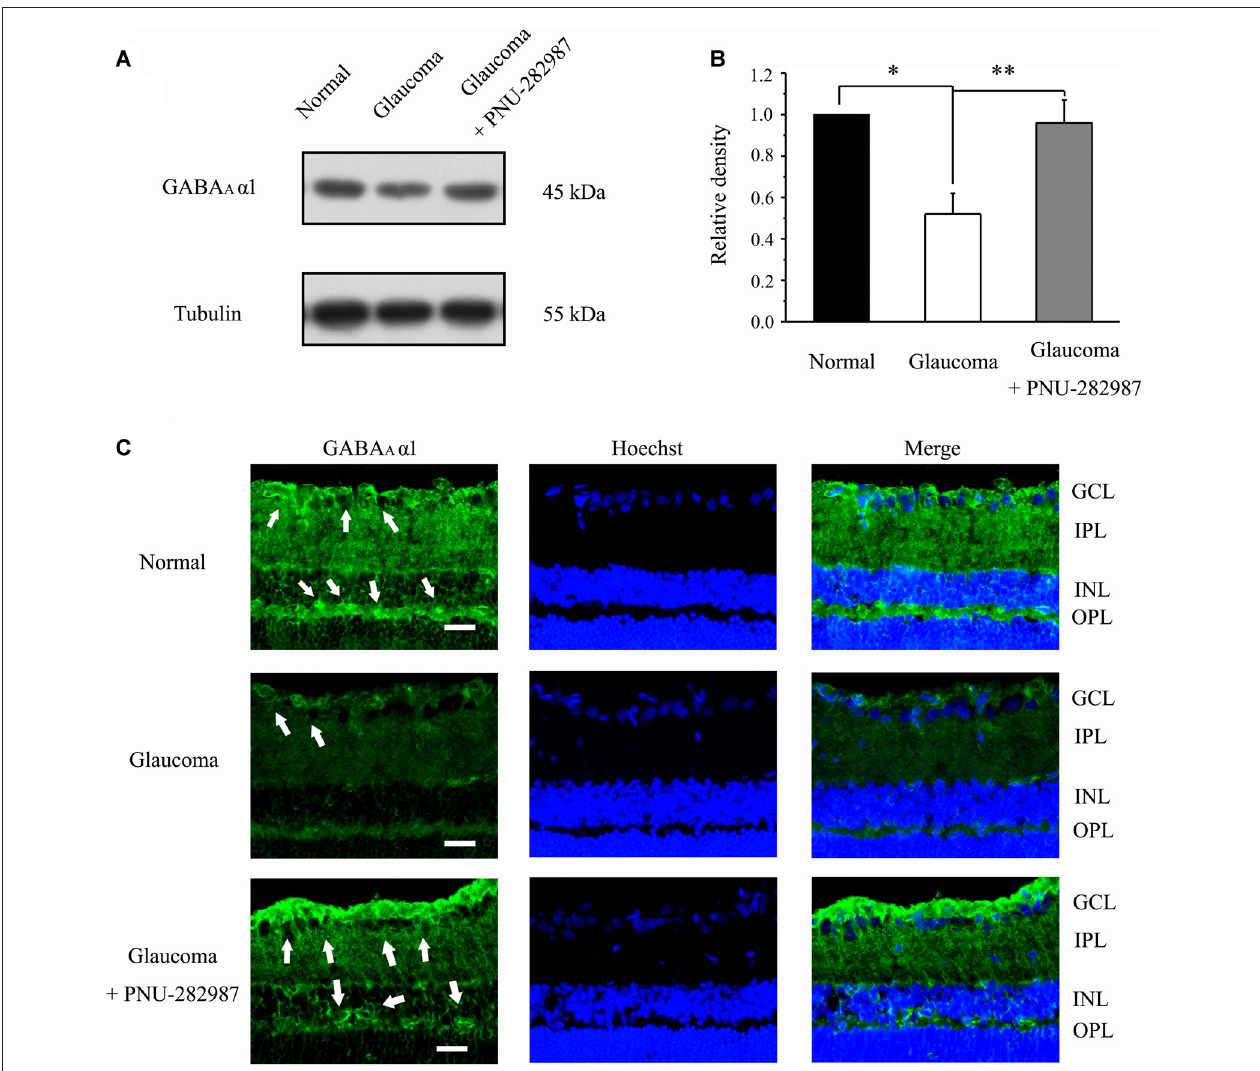
FIGURE 3 | Effect of PNU-282987 on the expression levels of the GABA receptor subunit GABAA α 1 in the retina. (A) Immunoblot analysis of GABAA α 1 in the retinas of control and glaucomatous rats before and after PNU-282987 injection. Full-length blots are presented in Supplementary Figure S1. (B) Quantitative analysis of GABAA α 1 expression. (C) Immunohistochemical analysis of the rat retina with antibodies against GABAA α 1 labeled in ganglion cell layer (GCL; arrow) and outer plexiform layer (OPL; arrow) in the normal, glaucoma and glaucoma + PNU-282987 conditions. GCL, ganglion cell layer; IPL, inner plexiform layer; INL, inner nuclear layer; OPL, outer plexiform layer. Scale bar: 15 µ m. The data are presented as the mean ± standard error of four samples for each experiment. ∗ p < 0.05, ∗∗ p < 0.01 (one-way analysis of